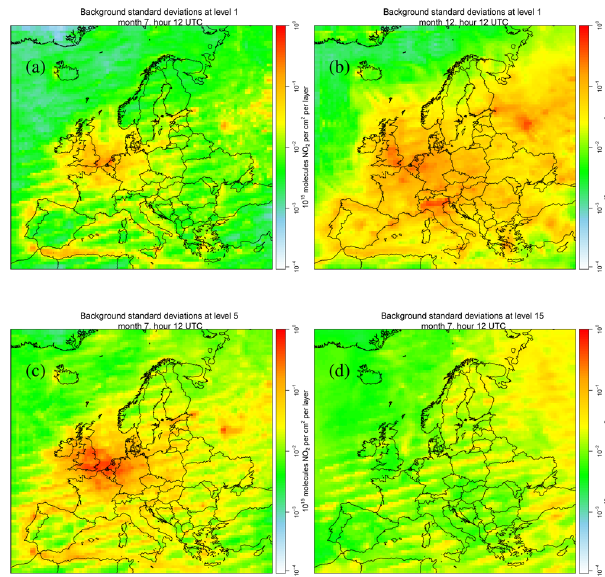
Fig. 6. Background error standard deviations, σ i ; m,h in July and December at the lowest model layer (top row), and for layers 5 and 15 in July (bottom row). Note that the colour scale denotes is loga-